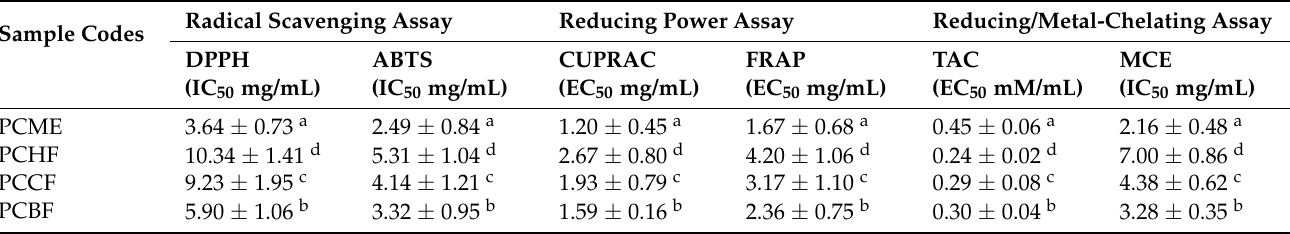
Figure 3. Antioxidant activities (mg and mM equivalents of standard antioxidants/g extract or fraction) of P. candollei . Table 4. IC 50 values of antioxidant activities of methanolic extract and different fractions of P. candollei (sample conc. 1